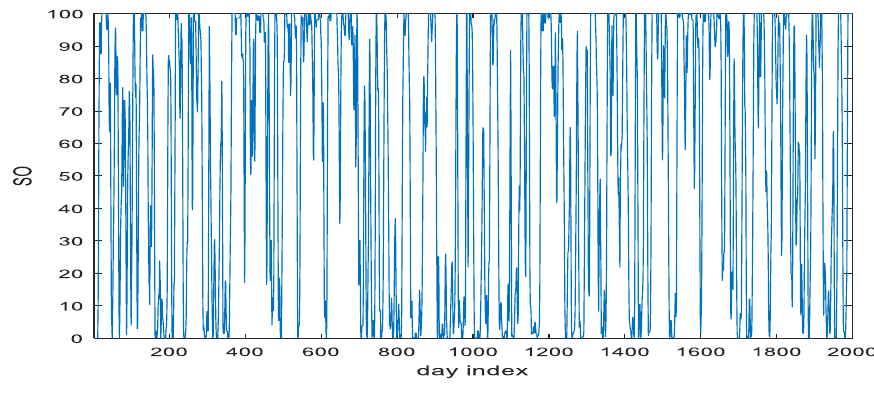
Figure 11. SO oscillator on test